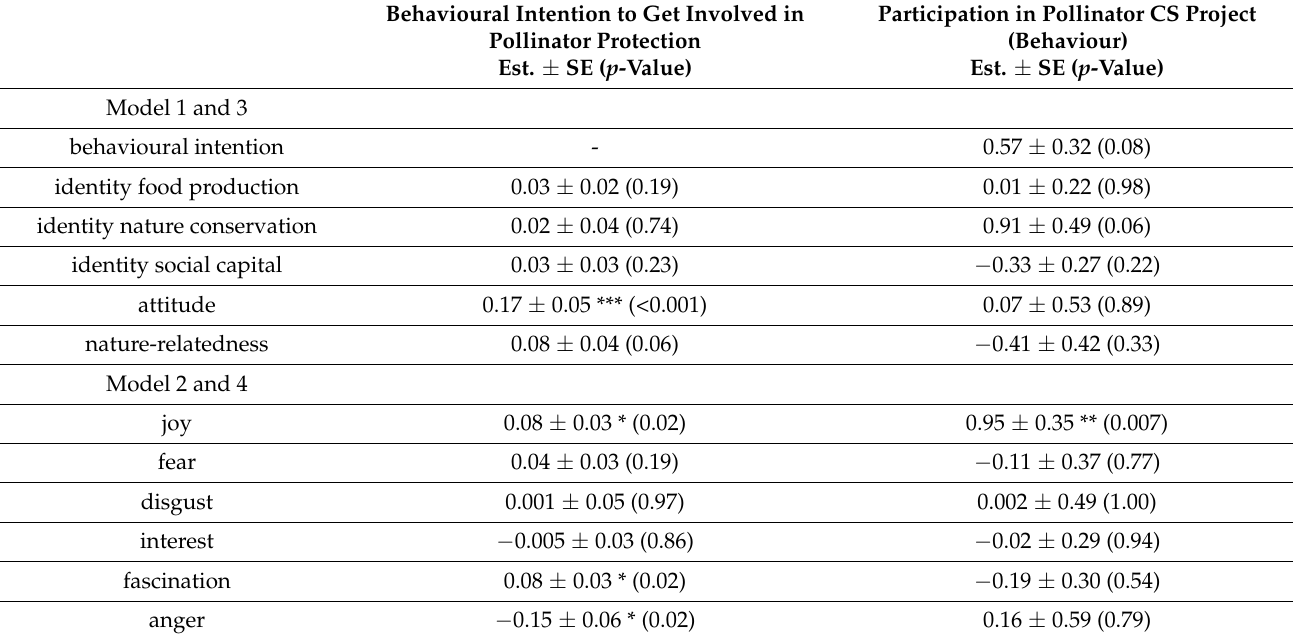
Table 3. Predictive potential of the constructs (identity, emotions, attitudes and nature-relatedness) to get involved in pollinator protection and predictive potential of these constructs in the participation of a CS project based on generalized linear models (effect sizes/-SE, GLMs), Model 1 and 2 included behavioural intention and model 3 and 4 participation as response variable in the models. Significance levels shown by * p < 0.05, ** p < 0.001, *** p <